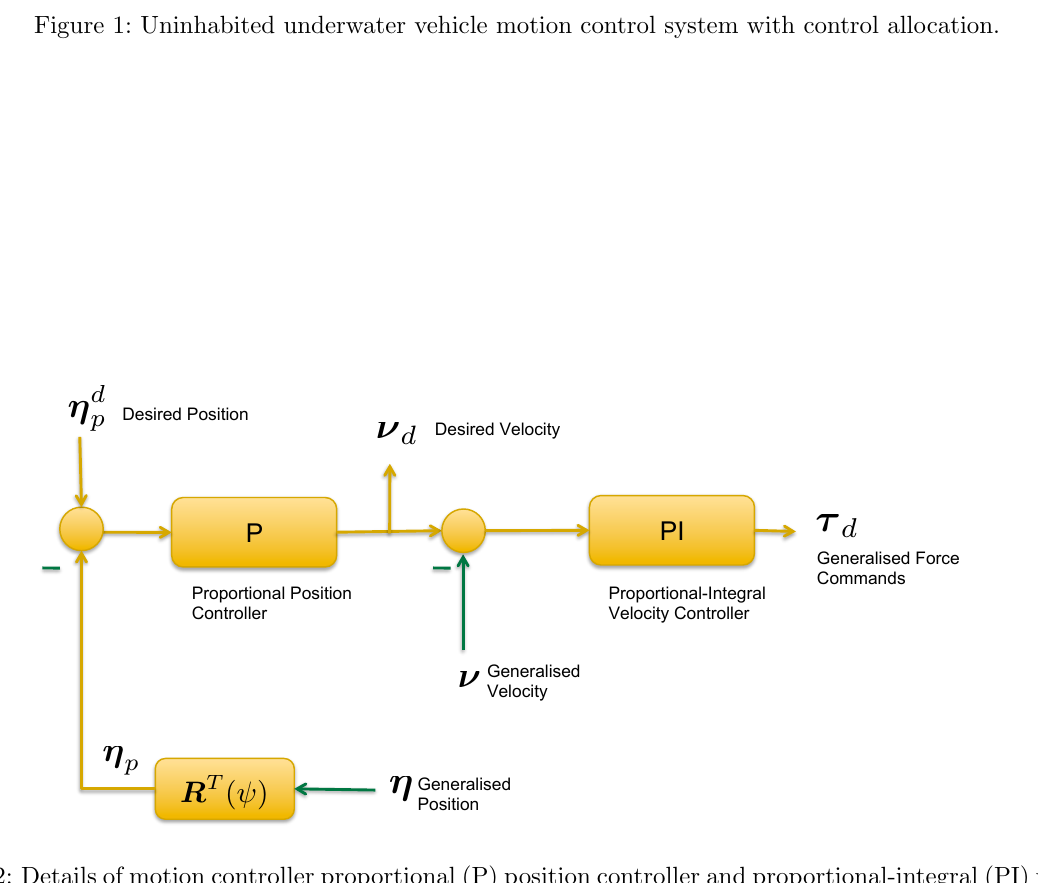
Figure 2: Details of motion controller proportional (P) position controller and proportional-integral (PI) velocity controller. For surface vessels, the generalized position and velocity vectors are wave-filtered before being used by the controller in this